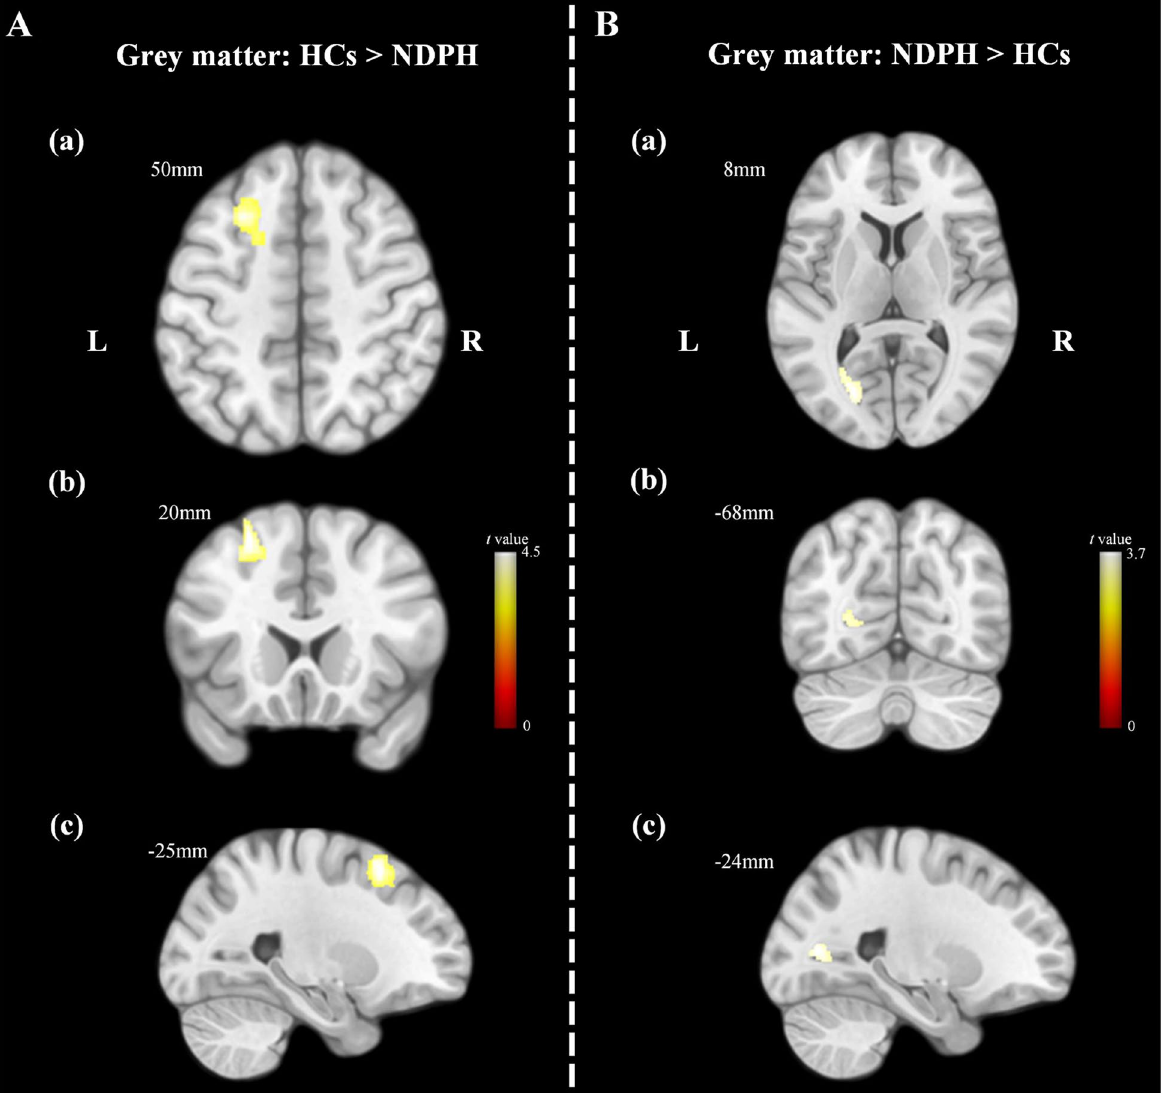
healthy controls; NDPH, new daily persistent headache; L Left; R